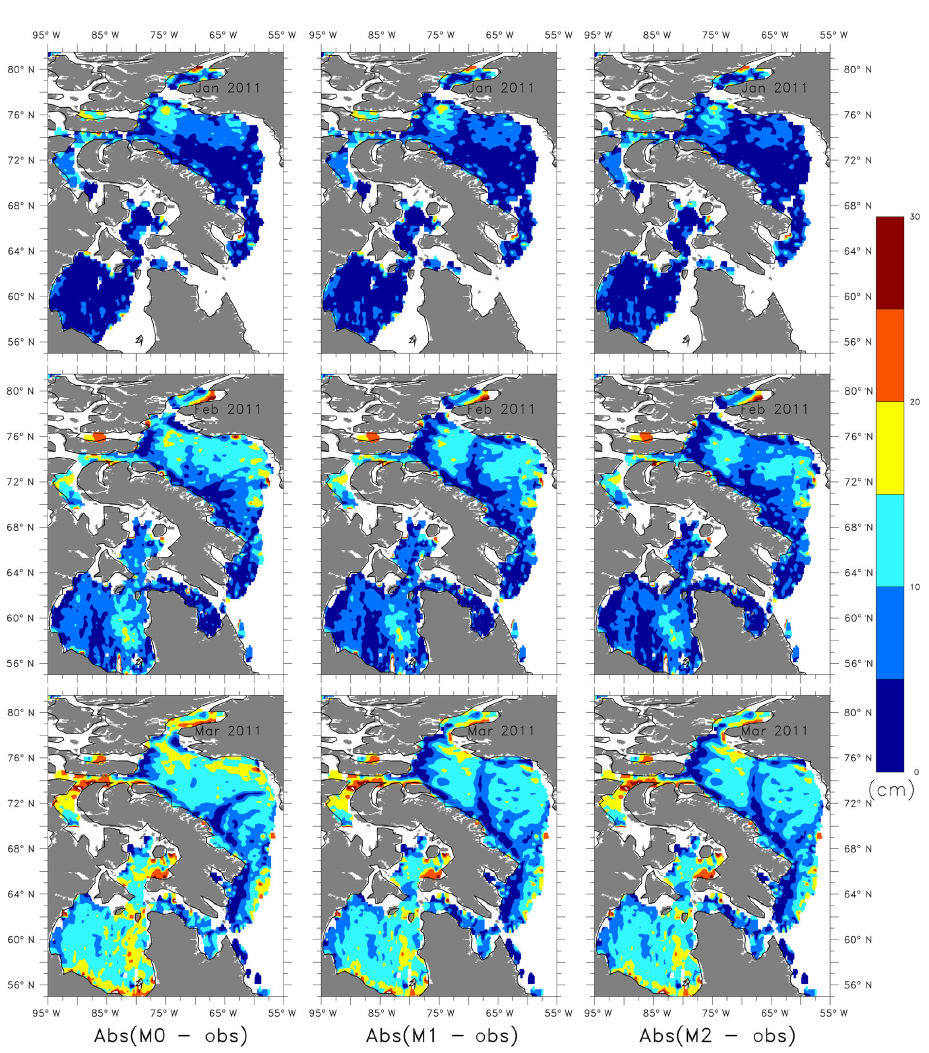
Figure 16. The absolute mean difference between the model freeboard for M0, M1 and M2 and CryoSat-2 for January, February and March 2011.